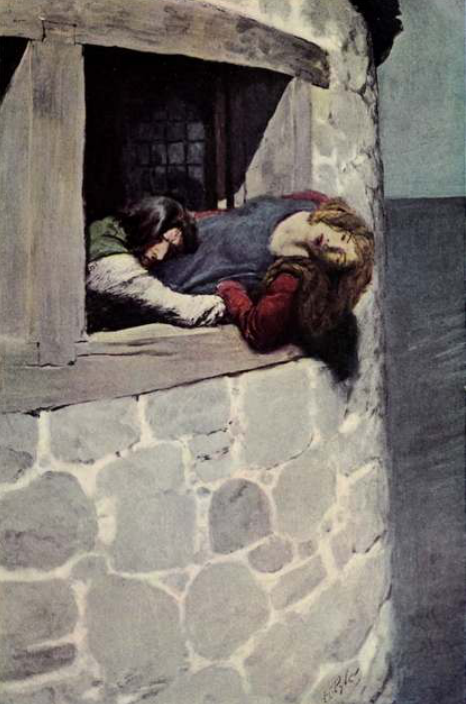
Figure 1. Howard Pyle, Her head and shoulders hung over the space without